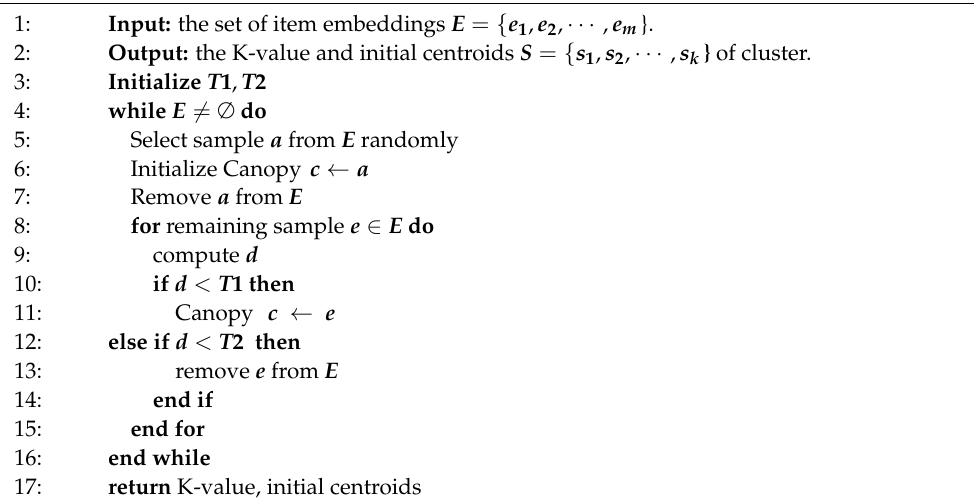
Figure 5. The description of the Canopy+K-Means algorithm, which contains two steps: ( a ) Canopy pre-clustering (Algorithm 1); ( b ) K-Means clustering. Algorithm 1. Pseudocode for Canopy clustering algorithm for embeddings.